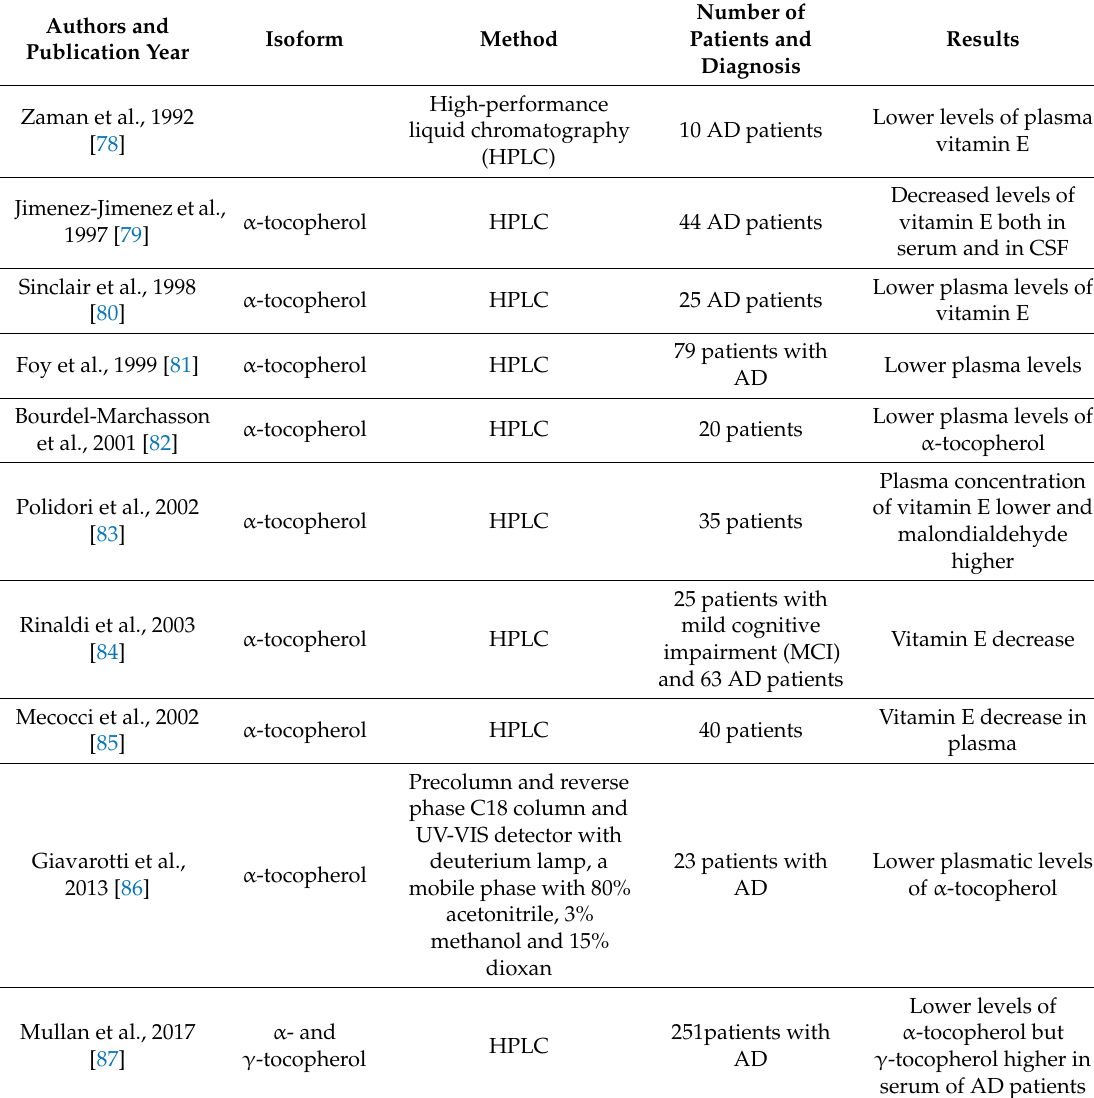
Table 1. Studies about the relation of Alzheimer’s disease and reduction of the vitamin E